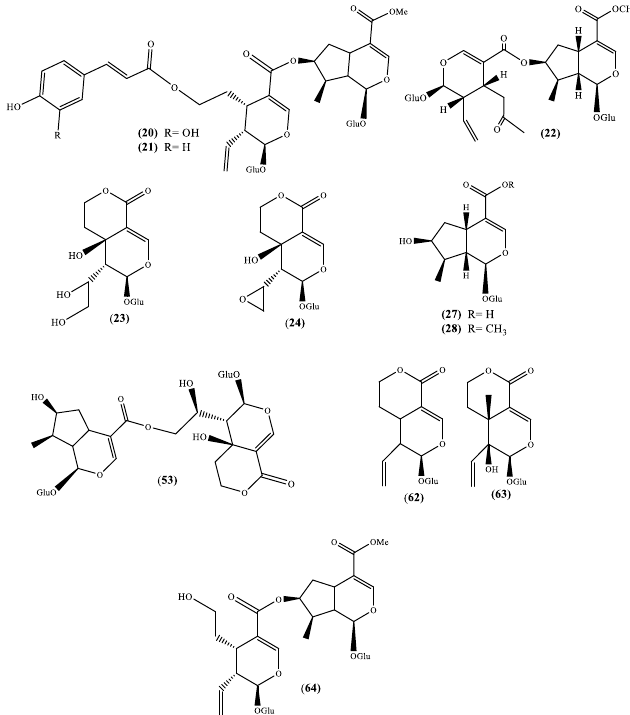
Figure 3. Iridoids isolated from the genus Scabiosa (Glu = glucose).